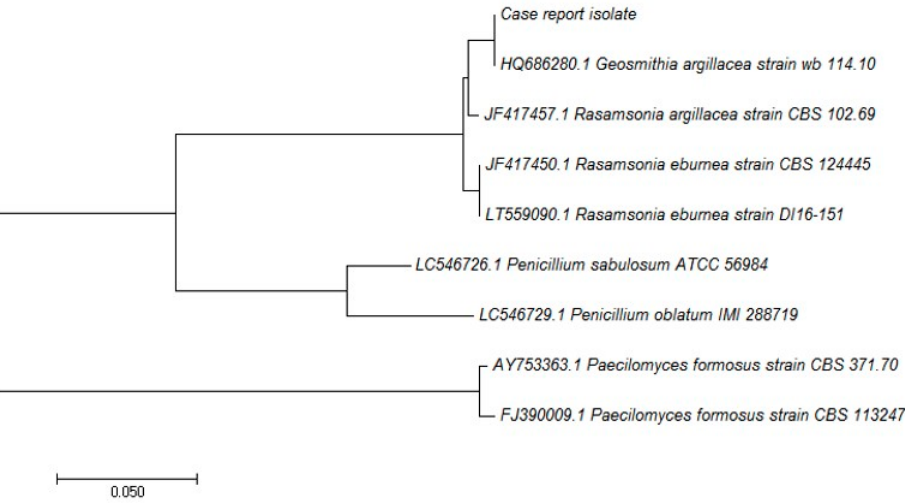
Figure 3. Phylogenetic